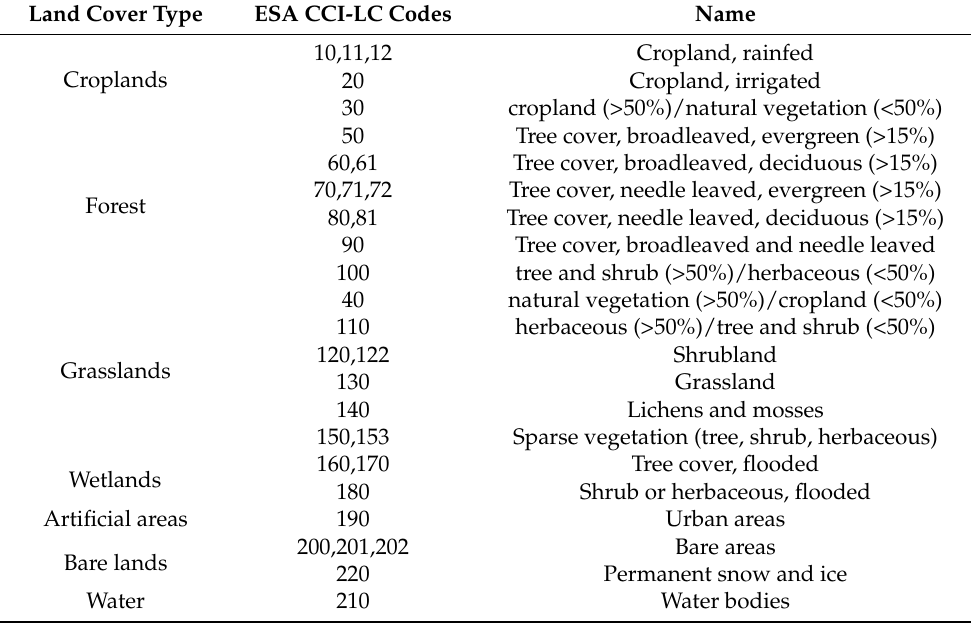
Table 2. Land cover reclassification based on the ESA-CCI land cover